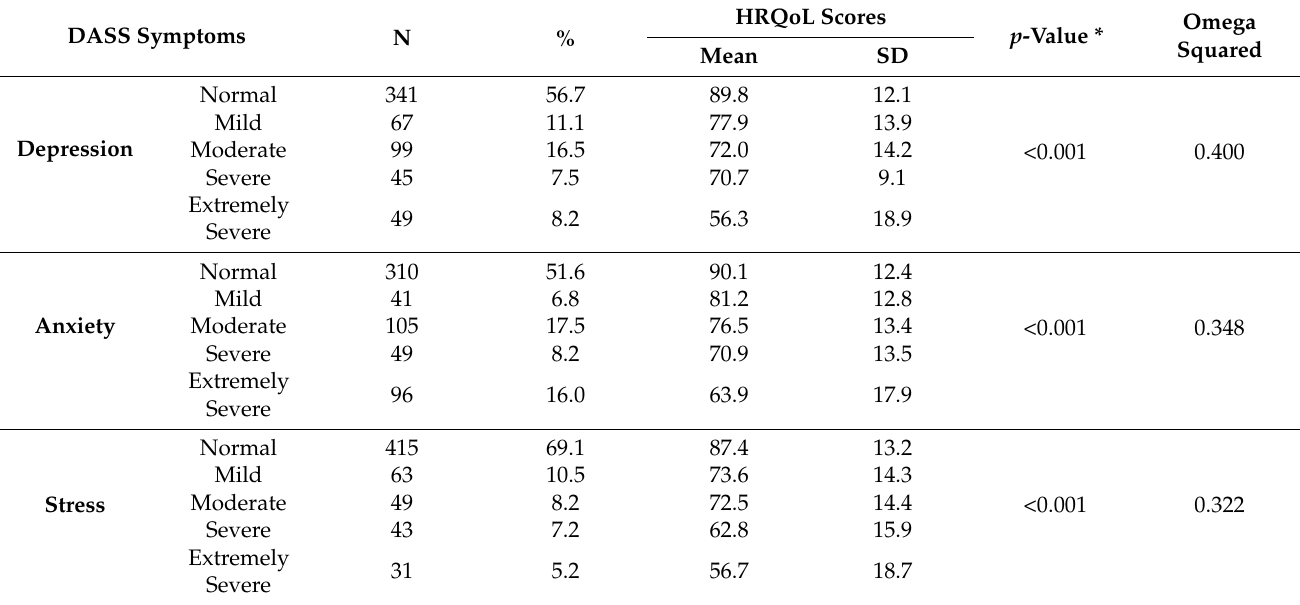
Table 3. The Depression, Anxiety, and Stress Scale—21 items (DASS21) (n = 601).